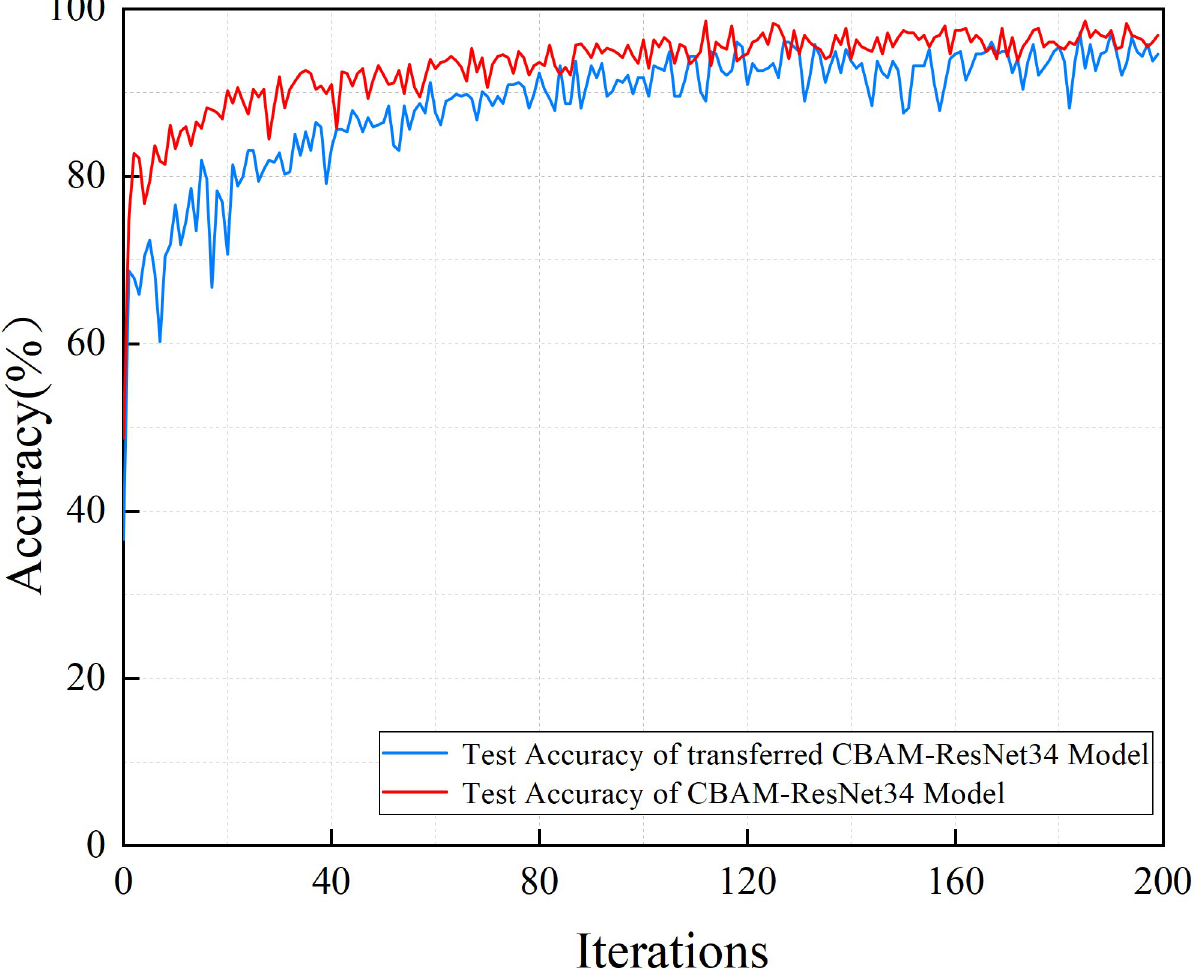
Fig 10. The training and validation accuracy of CBAM-ResNet34 and transferred CBAM-ResNet34 models are illustrated for comparison.